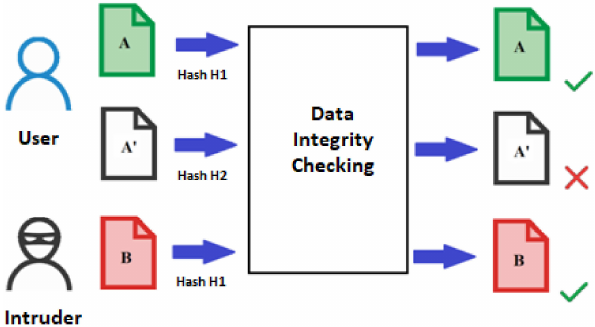
Figure 1. Scheme of a collision